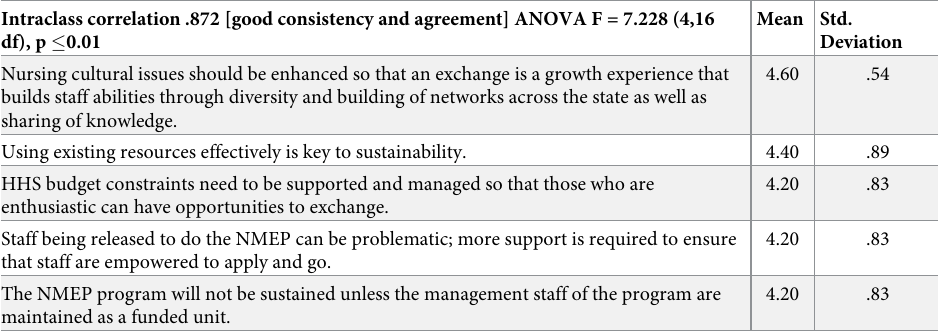
Table 12. Rate how you regard the following components in regard to CONTEXT RELATED FACTORS influenc- ing the success and sustainability of the NMEP program. Intraclass correlation .872 [good consistency and agreement] ANOVA F = 7.228 (4,16 df), p � 0.01